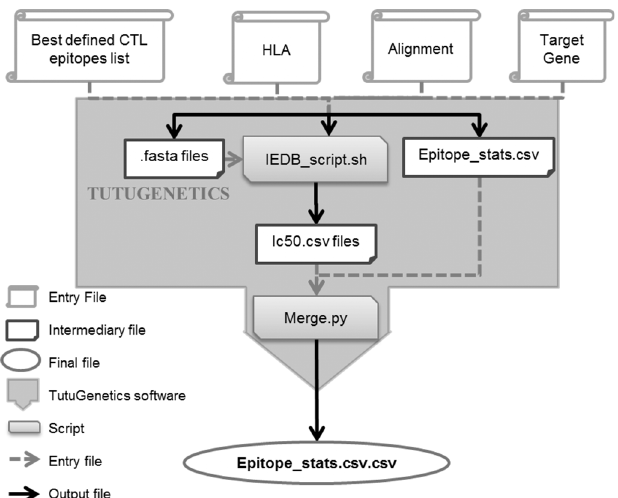
Fig 1. Description of TutuGenetics software. Four input files are used to generatean output final file mergingthe quantification (% variants) and qualification (amino-acidsequence)of the variabilityof HIV epitopes as well as their theoretical presentationto their HLA molecules(IC 50 value in nM). It allows the automatedanalysisof nucleicacid alignmentsfrom Sanger or UDPS sequences,corrects them (for the UDPS) and translates each read into its corresponding amino acids. Then, accordingto the HLA genotypeof the patient, it retrieves the CTL epitopes and their variants accordingto the Los Alamos HIV